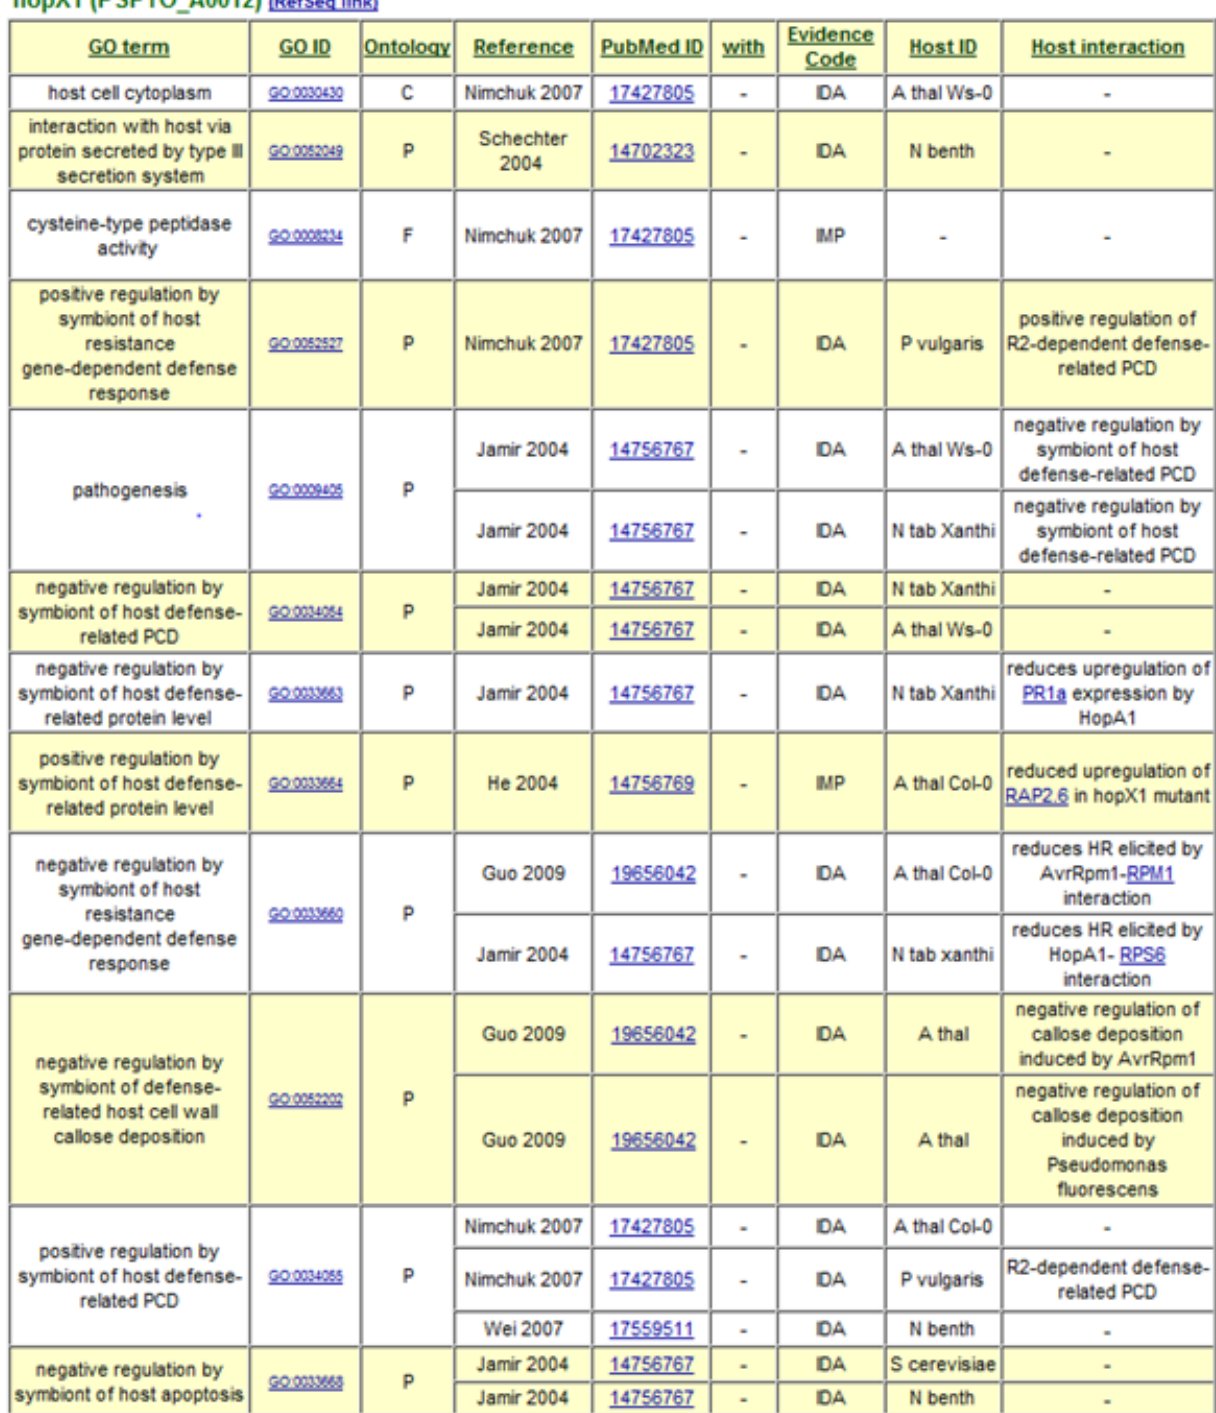
Figure 1. Gene ontology (GO) annotation term assignments for type III effector HopX1 from P. syringae pv. tomato . GO terms used fall into three separate ontologies corresponding to cellular component (C), molecular function (F), and biological process (P). First author and publication year of the source of the data are shown together with a hyperlinked Pubmed ID. A key to evidence codes can be found at